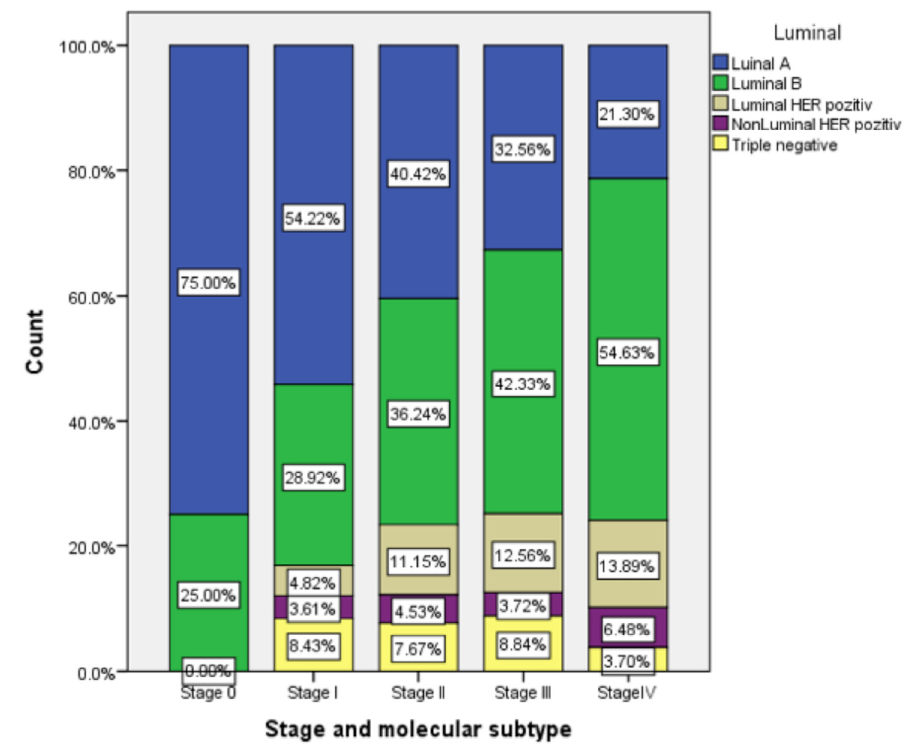
Figure 1. Stage of the disease related to molecular